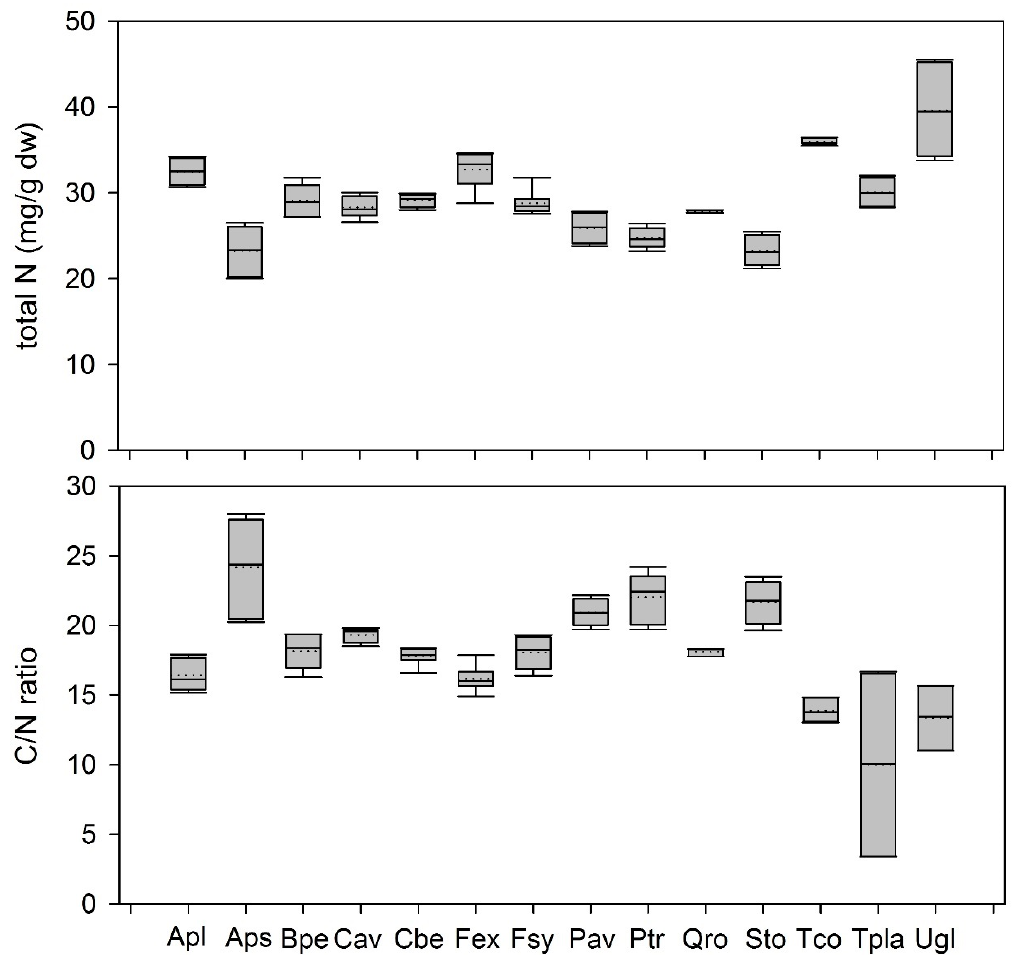
Figure 3. Total N concentration (mg/g dw) ( top ) and C/N ratio ( bottom ) in green leaves. Boxplots show mean (dotted line) and median (straight line) for the combined years. Data for Q. robur is only available for the first year. Apl = Acer platanoides , Aps = Acer pseudoplatanus , Bpe = Betula pendula , Cav = Corylus avellana , Cbe = Carpinus betulus , Fex = Fraxinus excelsior , Fsy = Fagus sylvatica , Pav = Prunus avium , Ptr = Populus tremula , Qro = Quercus robur , Sto = Sorbus torminalis , Tco = Tilia cordata , Tpla = Tilia platyphyllos , Ugl = Ulmus glabra .